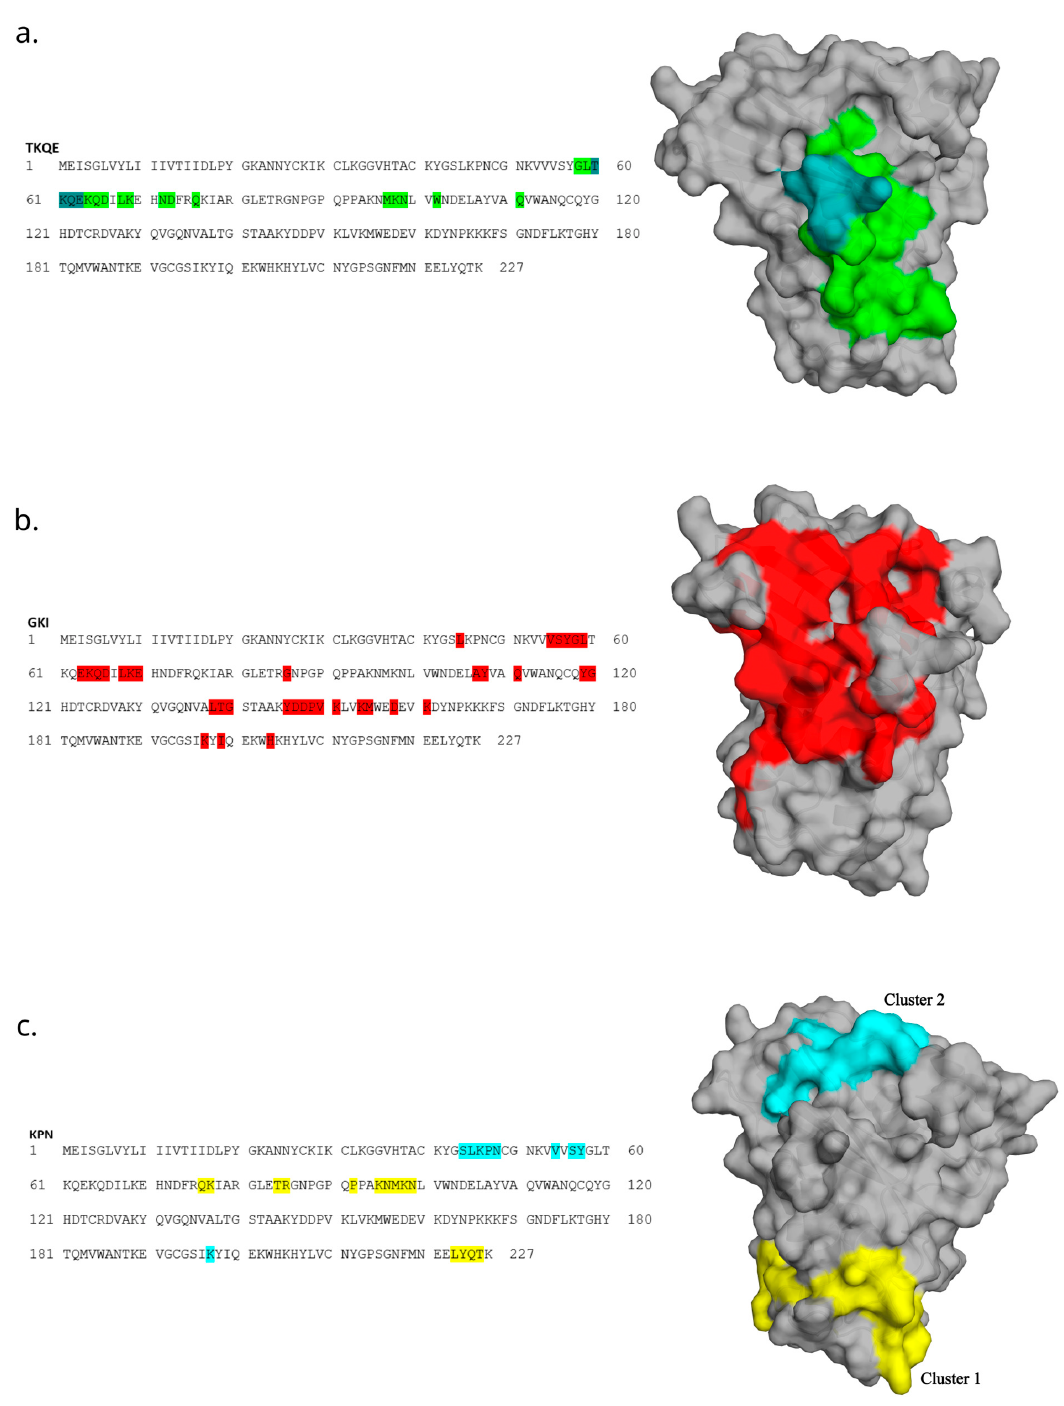
Motif-containing peptides were then mapped onto a 3D model of allergen Ves v 5 using the Pepitope tool [23]. With this approach, we could obtain the predicted areas of the allergen that bind to an antibody. (Figure 7). The best clusters are presented graphically.